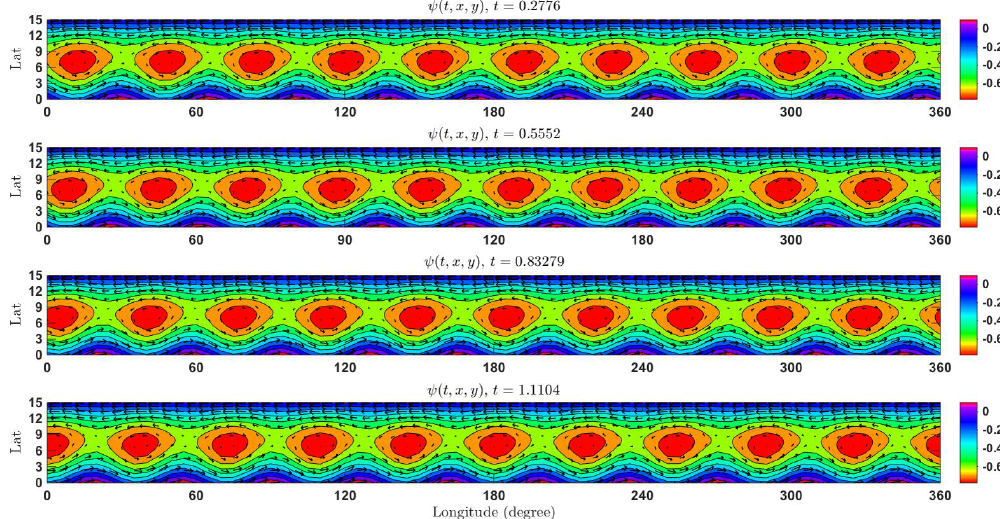
Figure 4. Illustration of the streamfunction ψ for the new periodic state on the central manifold near the critical point R ∗ after the dynamical transition, assuming (cid:15) = 0 . 3, E = 0 . 05, and R = 3 . 8717 > R ∗ = 3 . 8517. The nondimensional period is T = 2 . 776, which corresponds to a physical period of ∼ 3 . 213d. Superimposed are corresponding vector flows derived from the